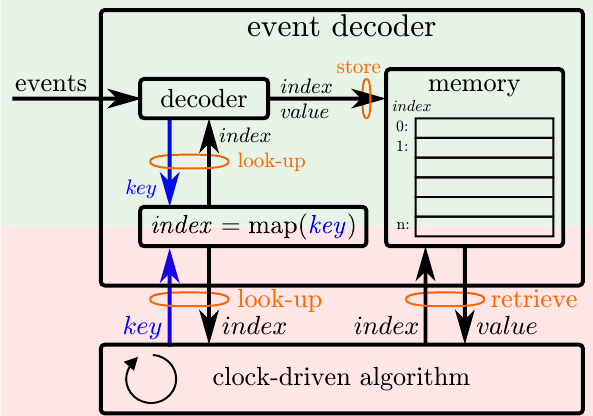
Figure 6. The event decoder provides an interface to transfer information from the event-driven domain (green background) to the clock-driven domain (red